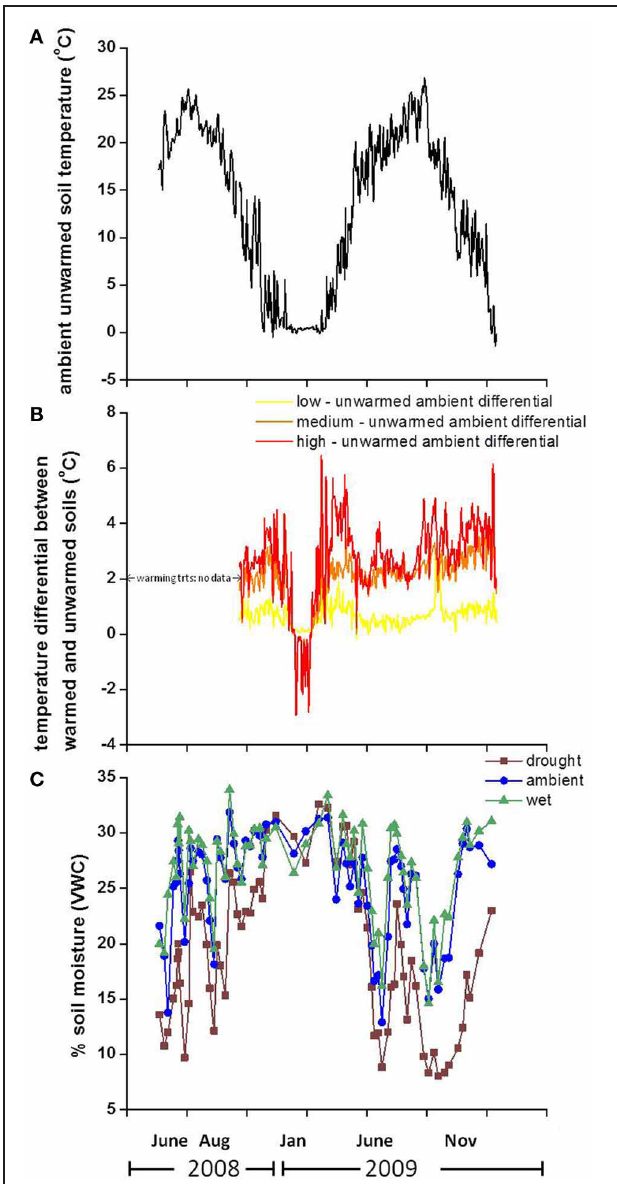
FIGURE 1 | Soil temperature in the ambient precipitation, unwarmed treatment in 2008 and 2009 (A), the temperature differential between warmed and unwarmed soils (B) and % volumetric soil moisture in 2008 and 2009 (C) by precipitation treatment. The displayed soil temperature values are from 2cm below the surface and the moisture panel depicts moisture in the top 10cm of